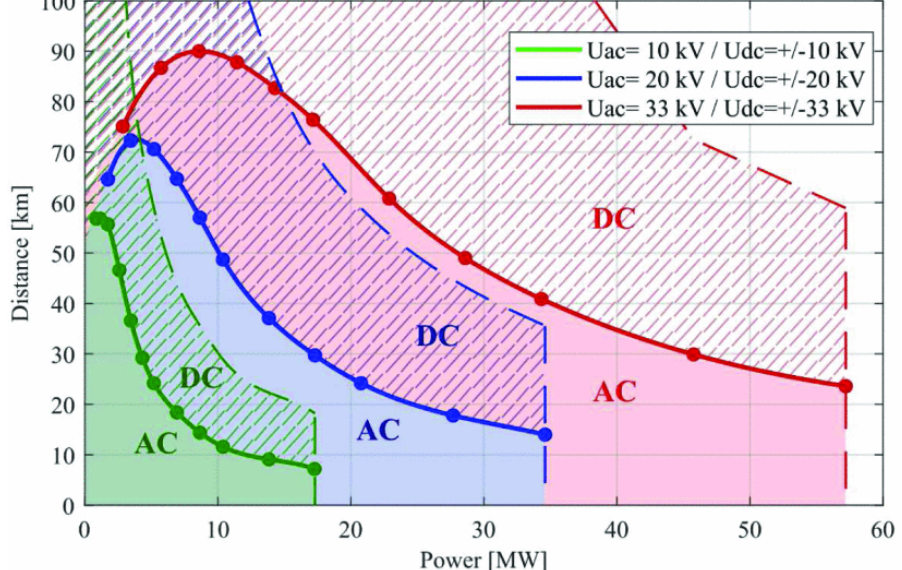
21 of 31 Figure 10. Modified 5-bus radial MVDC distribution system. The losses were evaluated by assuming nominal voltage and current ratings of ±33 kV and 2 – 2.5 kA, respectively. Bidirectional power flows from PV farms integrated in ei- ther the transmission or distribution network are possible. The distance for the MVDC distribution bus was fixed between 30 and 50 km (kms). As is evident in Figure 11, at distances above 50 km, the power-carrying capacity of the 33 kV MVDC is the most effi- cient. It can be observed that as the transmitted power capacity decreases, the DC ’s po- tential power-transmission distance becomes longer. The capacity current in AC systems at low power and long distances degrades the efficiency noticeably [79]. Additionally, the MVAC distribution efficiency ranges from 91.6% to 94.7%, and the DC transmission effi- ciency ranges from 97.4% to 98.6%. These numbers were taken from the worst-case sce- nario of maximum daily load profile, as modelled in Section 4. The total combined maxi-